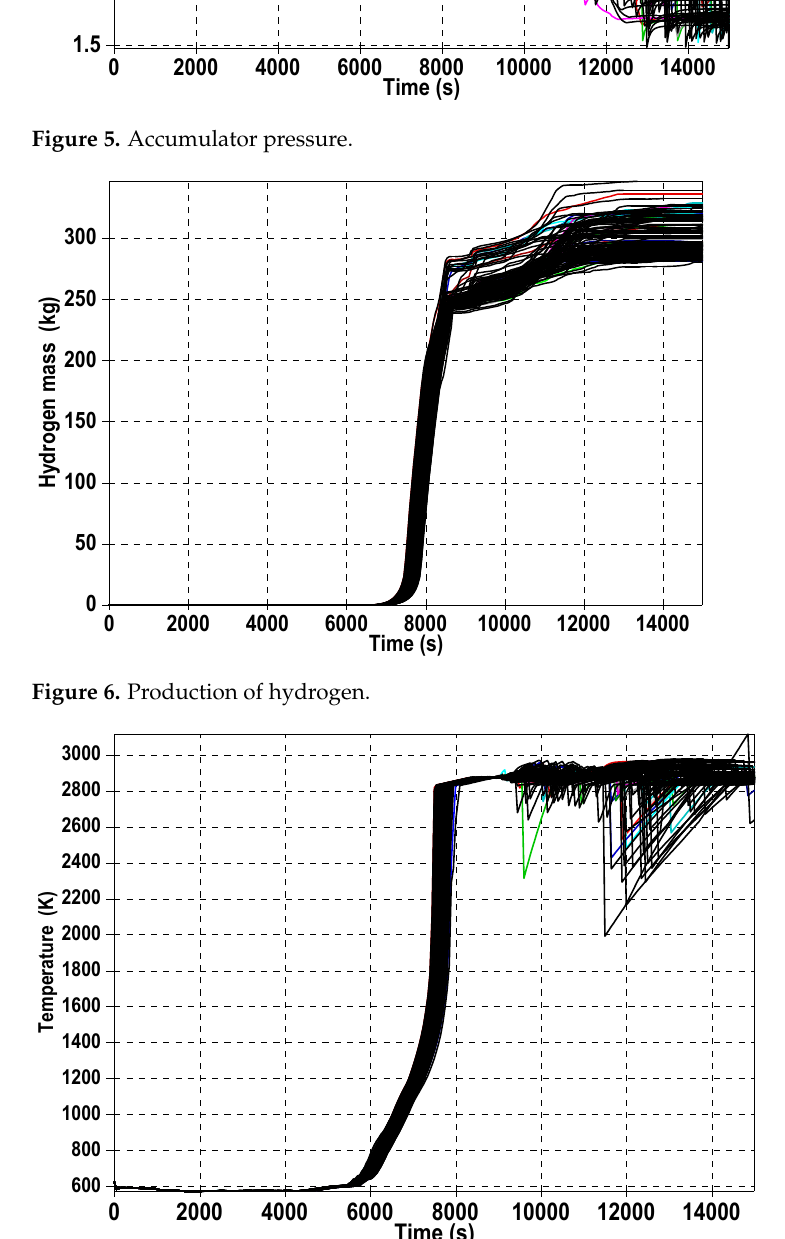
Figure 8. Radius of the in-core molten pool. Figure 9 shows corium height in the lower head. The relocation of corium to the lower head represents a turning point in the further course of the accident because after that there is a significant scattering in the results. The interaction of corium and water in the lower plenum causes swift evaporation and an increase in the primary pressure. The pres- sure dynamics, but more generally the thermal hydraulic plant feedback, ultimately de- termine the operating time of the accumulators and other events caused by their activa- tion. Emptying of the in-core molten pool affects both the thermohydraulic behaviour and the progression of a severe accident. Thus, after the corium relocation, there is no longer a clear pattern of events between different scenarios, but the key events take place at dif- ferent times, leaving the impression of a stochastic distribution of results.